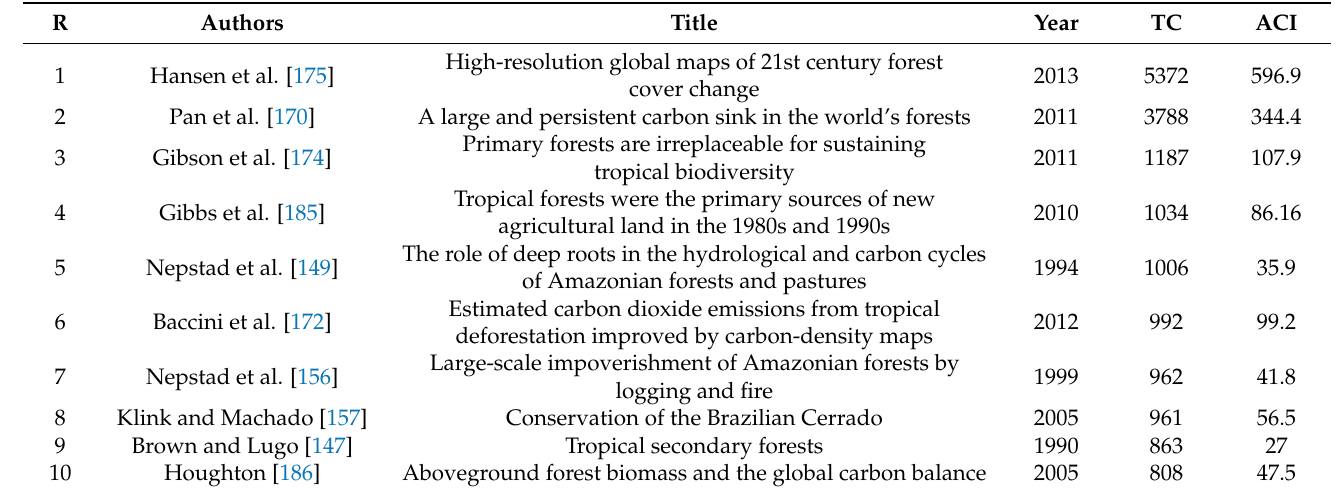
Table 1. Top 10 frequently cited documents during 1978–2021 on LULC in tropical forests. R = rank; TC = total number of citations received for document; ACI = annual citation